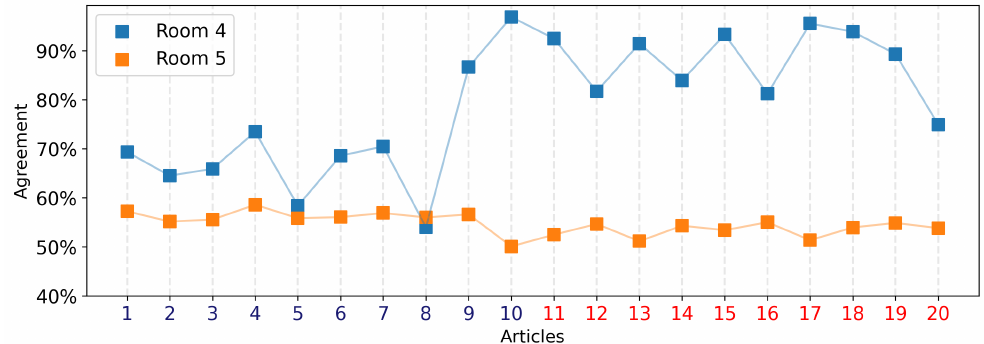
Figure 6. Agreement of users with the social ratings (Room 4, blue) and random ratings (Room 5, orange). Users conform to social ratings much more than random, inconsistent ones. Random ratings are likely trusted slightly more over true news, where users are probably more hesitant, than over false news. Similarly, social ratings were likely more helpful for false news than true